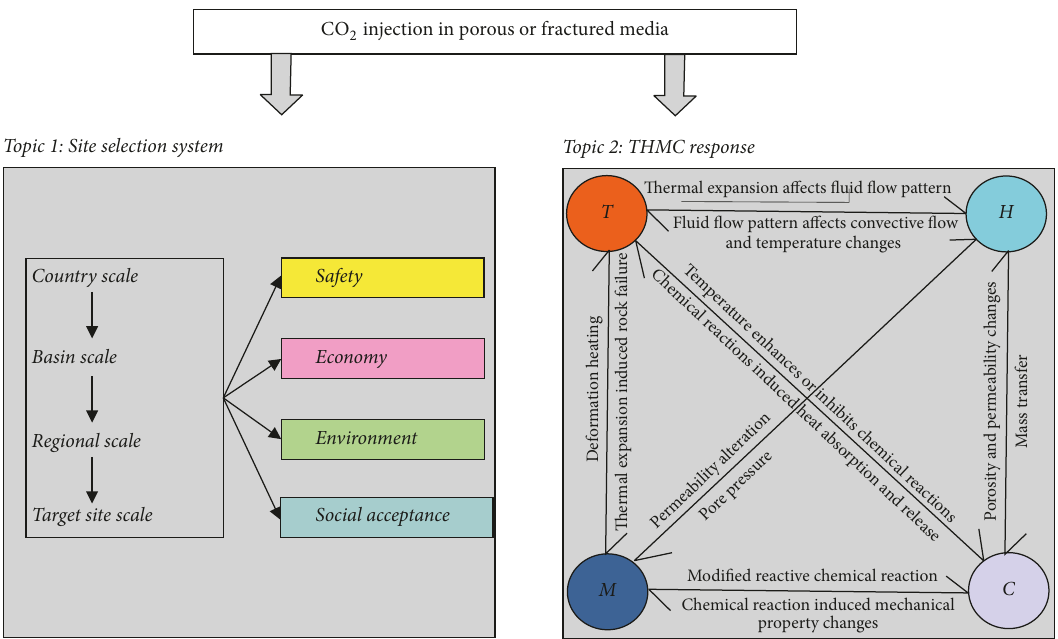
Figure 2: Schematics of the two main topics, that is, the site selection system ( 1 ) and the THMC responses ( 2 ) associated with CCS and CCUS